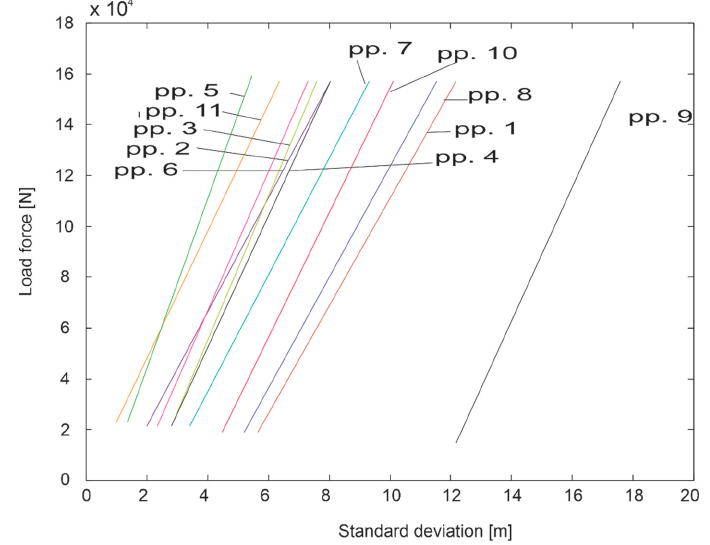
Figure 4. Approximation of the function P(z) by a straight line.